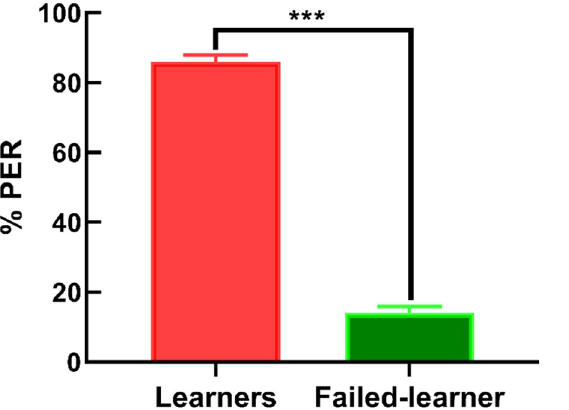
Fig 2. Proboscis extension response learning trials of A . mellifera bees to odor response and sucrose reward. PER (%) exhibited that learner bees significantly higher learner response as compared to failed learner bees, x-axis and y- axis represents the learner and failed-learner bees and percentage of proboscis extension response